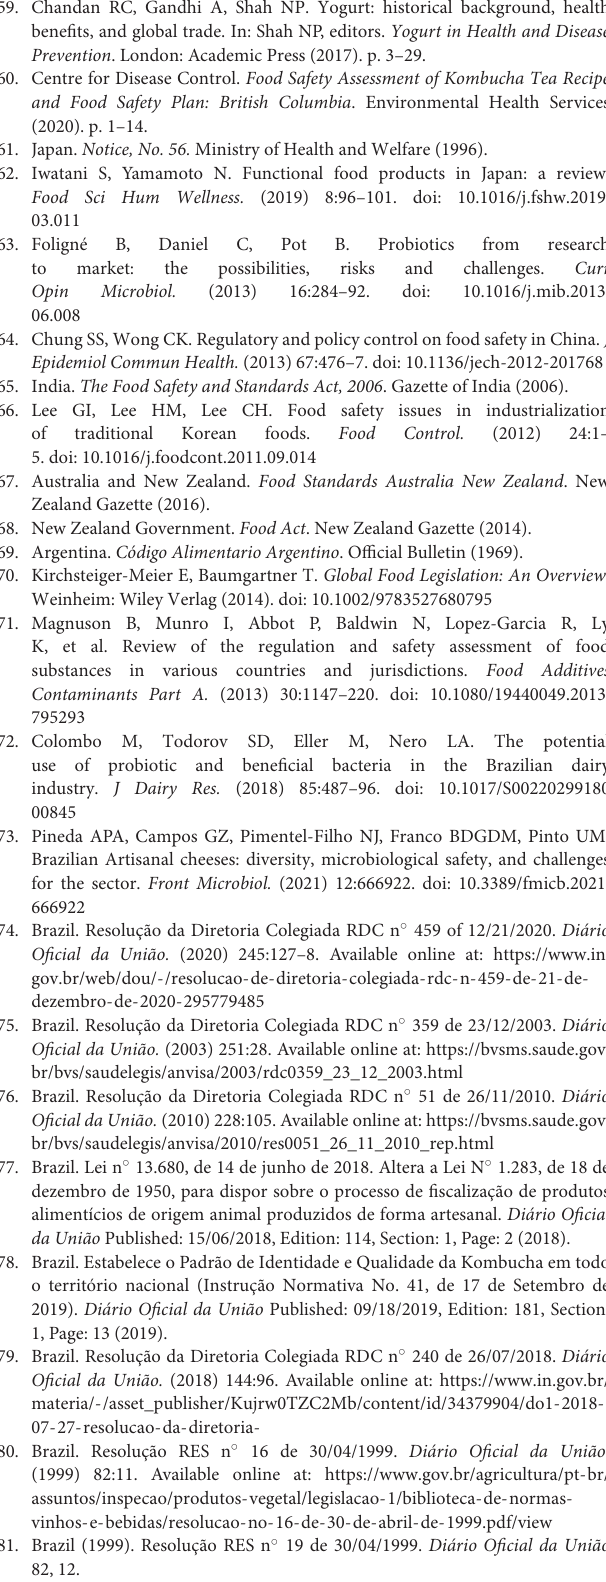
down the general principles and requirements of food law, establishing the European Food Safety Authority and laying down procedures in matters of food safety. Off J Eur Commun L. (2002) 31:1–24. Available online at: http:// data.europa.eu/eli/reg/2015/2283/oj 43. European Parliament and Council of the European Union. Regulation (EU) 2015/2283 of the European Parliament and of the Council of 25 November 2015 on novel foods, amending Regulation (EU) No 1169/2011 of the European Parliament and of the Council and repealing Regulation (EC) No 258/97 of the European Parliament and of the Council and Commission Regulation (EC) No 1852/2001. Off J Europ Union. (2015) 327:1–22. 44. Efsa Panel on Dietetic Products, Nutrition and Allergies. Scientific Opinion on the substantiation of health claims related to live yoghurt cultures and improved lactose digestion (ID 1143, 2976) pursuant to Article 13(1) of Regulation (EC) No